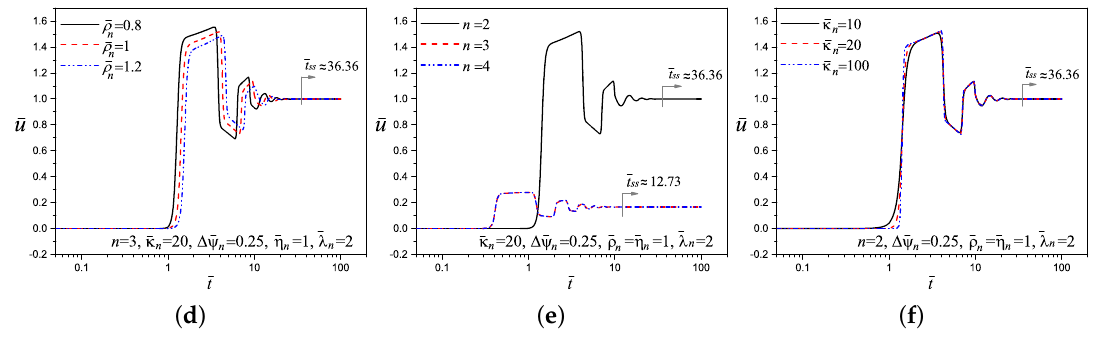
Figure 8. Tracking of the velocity in the multi-layer flow as a function of the dimensionless time evaluated in the center of the microchannel at ¯ y = 1 and with ¯ (cid:101) n = 1, for: ( a ) effect of ∆ ¯ ψ n (from Figure 4), ( b ) effect of ¯ λ n (from Figure 5), ( c ) effect of ¯ η n (from Figure 6), ( d ) effect of ¯ ρ n , ( e ) effect of number of layers n , and ( f ) effect of ¯ κ n